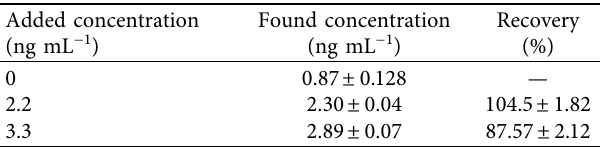
Table 2: Analytical results for determination of DCS in tap water sample by the developed